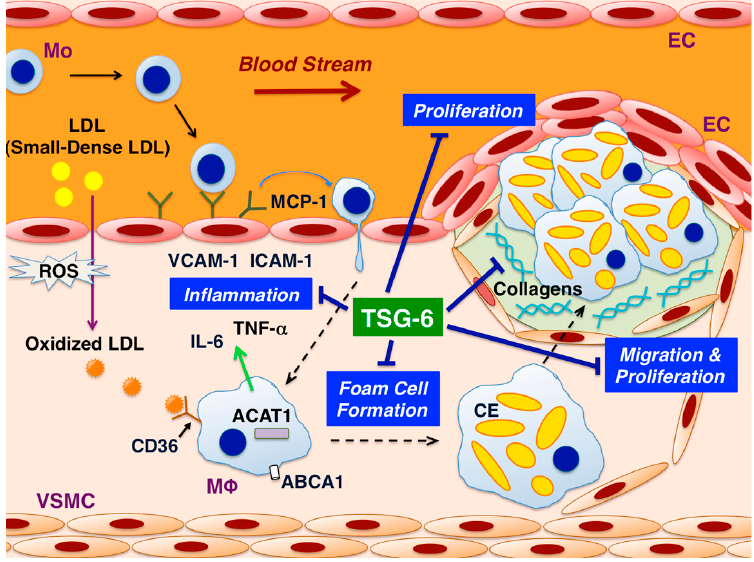
Figure 1. Mechanisms underlying the atheroprotective effects of tumor necrosis factor-stimulated gene-6 (TSG-6). This figure illustrates the suppressive effects of TSG-6 on atherosclerotic plaque formation in the arterial wall. TSG-6 prevents atherosclerosis by suppressing the inflammatory responses in endothelial cells (ECs) and macrophages, oxidized low-density lipoprotein (LDL)-induced foam cell formation in macrophages, and the migration and proliferation of vascular smooth muscle cells (VSMCs). TSG-6 increases the production of collagen-1 and -3 by VSMCs. Abbreviations: ACAT1 = acyl-coenzyme A:cholesterol acyltransferase-1; ABCA1 = ATP-binding cassette transporter A1; CE = cholesterol ester; ICAM-1 = intercellular adhesion molecule-1; MCP-1 = monocyte chemotactic protein-1; Mo = monocyte; M Φ = macrophage; ROS = reactive oxygen species; VCAM-1 = vascular cell adhesion molecule-1.